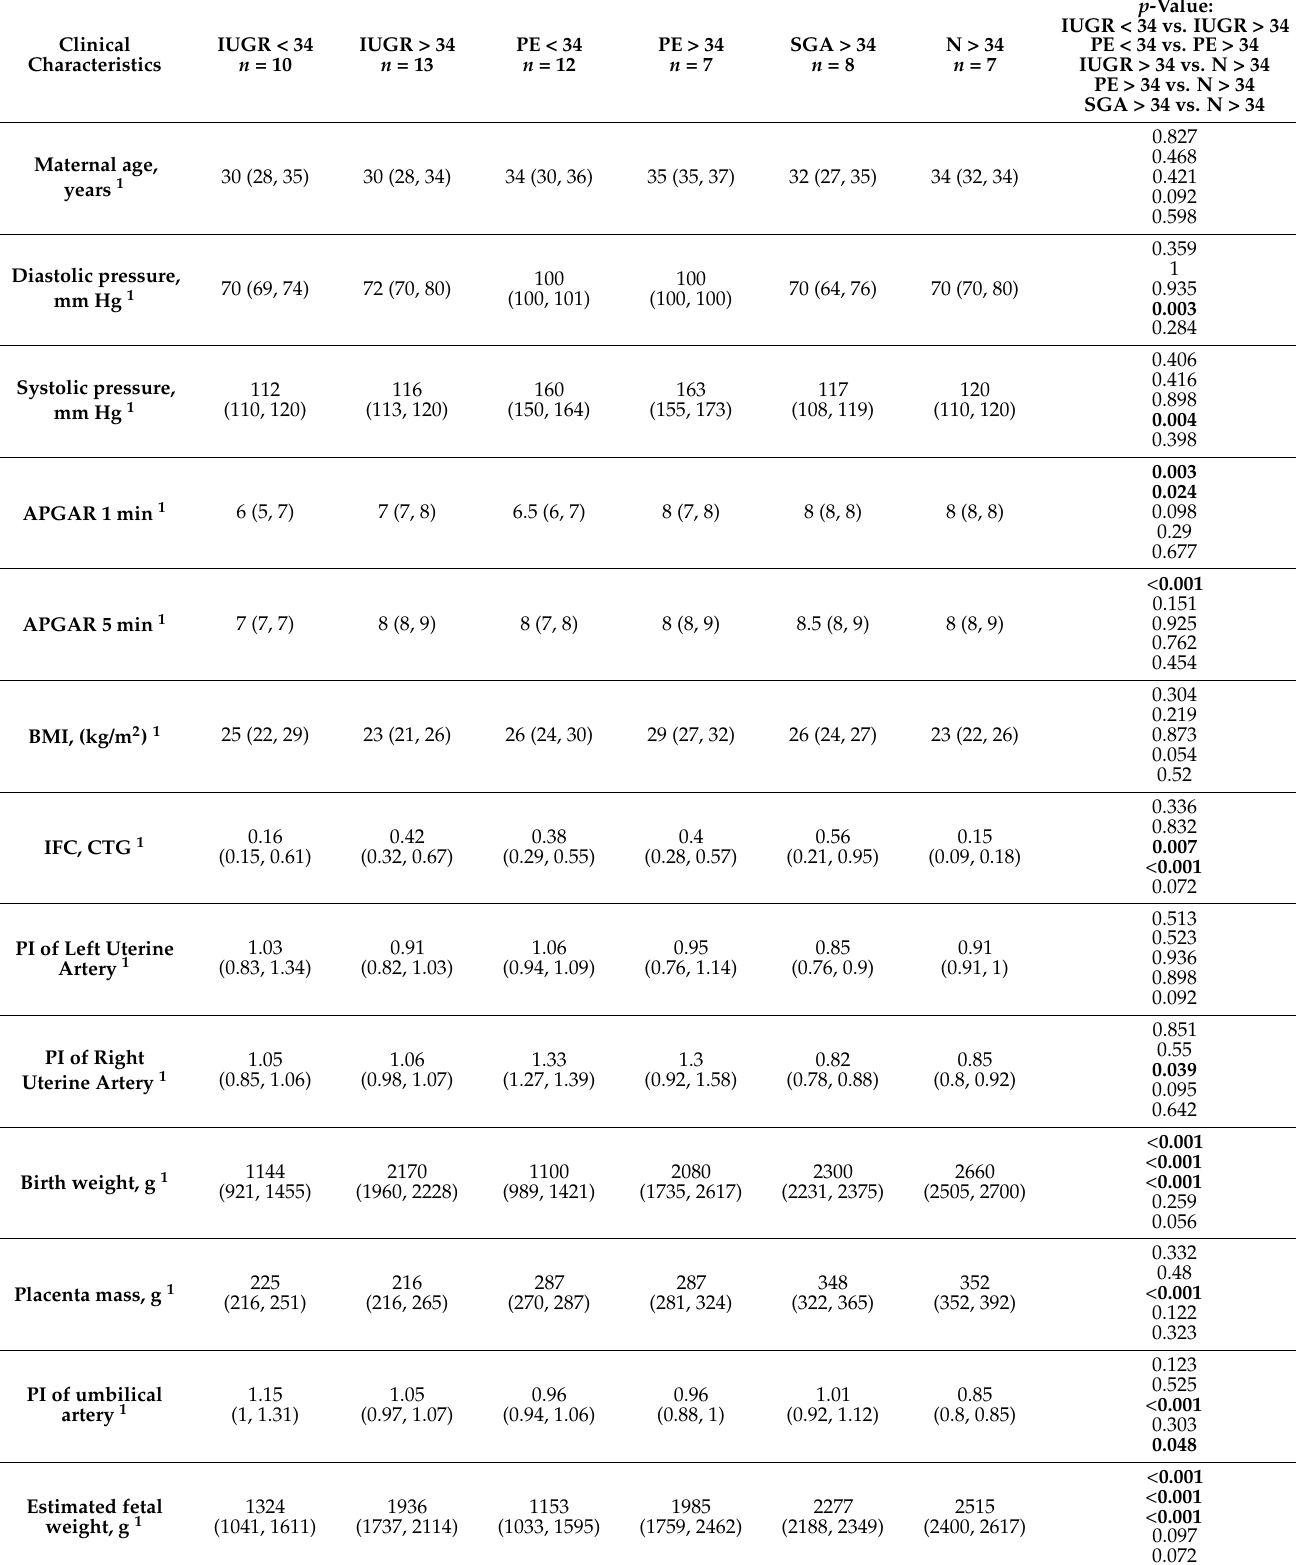
Table 1. Parameters of patients’ clinical characteristics, ultrasonography, and Doppler